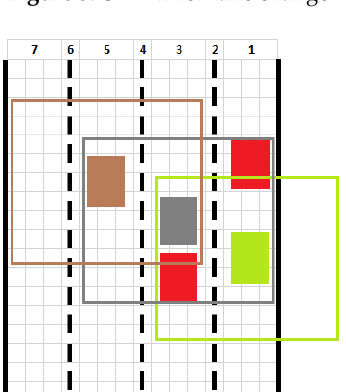
Figure 5. S MA il for lane change.